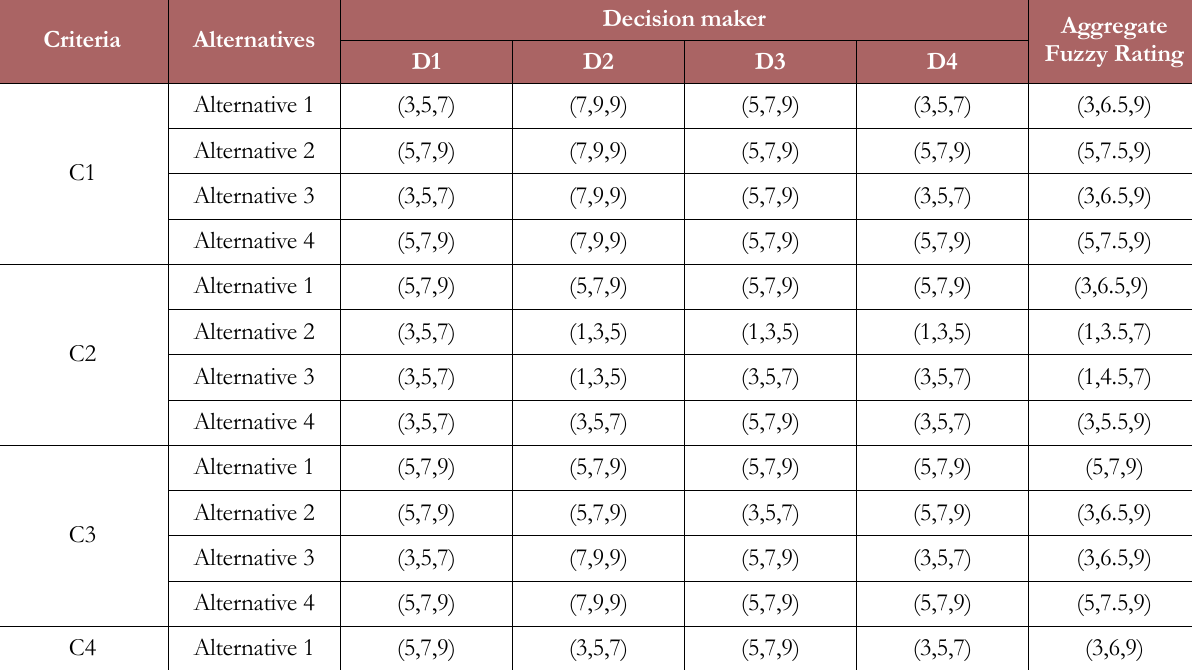
Table 8. Aggregate fuzzy weights for